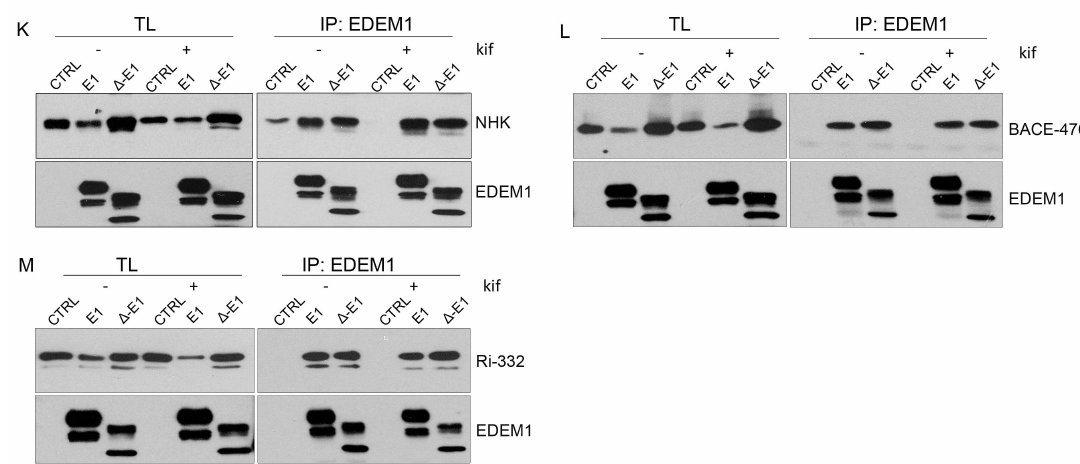
Figure 2. EDEM1 accelerates proteasomal degradation of ERAD substrates. ( A ) HEK293T cells co-expressing an empty vector (CTRL), α -1 antitrypsin ( α -1AT), the Null Hong Kong (NHK) mutant with EDEM1, or an empty vector (-) were treated or not with MG132. The cells were lysed in Triton-X100-containing bu ff er, and an equal amount of protein was separated in polyacrylamide gels in reducing conditions for each sample. Protein expression was detected by Western blotting